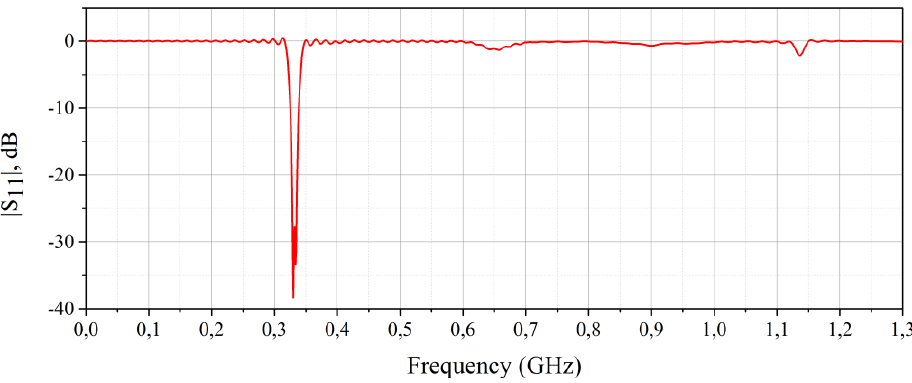
Fig. 2. |S 11 | in a wide band of frequencies .